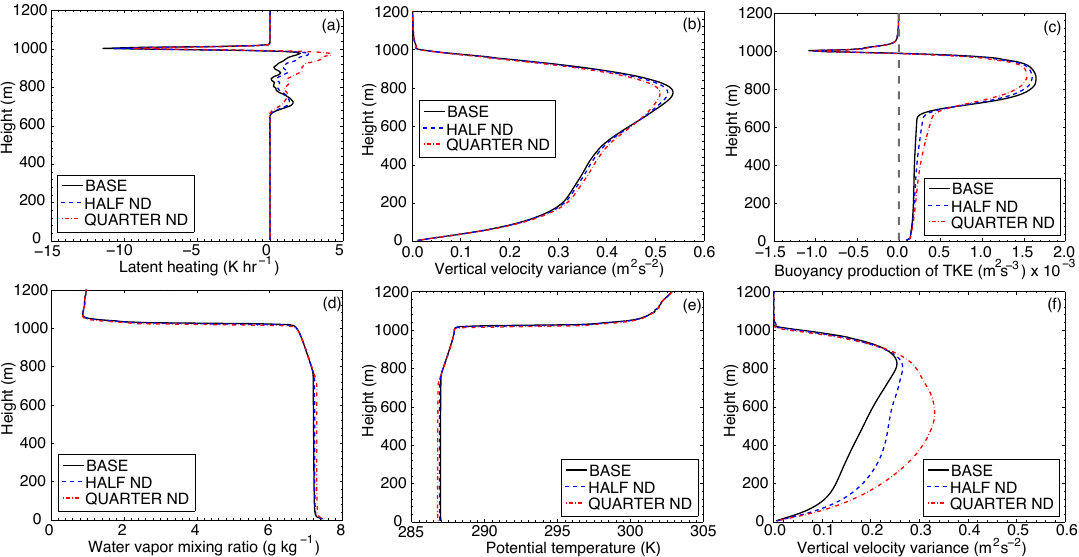
Fig. 9. LES output showing STBL response for changes in aerosol and cloud droplet concentrations. Vertical profiles, shown in (a) to (c) , are domain averaged and temporally averaged over the first fifteen minutes of simulation after perturbation (09:30 to 09:45UTC). Vertical profiles, shown in (d) to (f) , are domain averaged and temporally averaged over the hour of observation (12:30 to 13:30UTC).